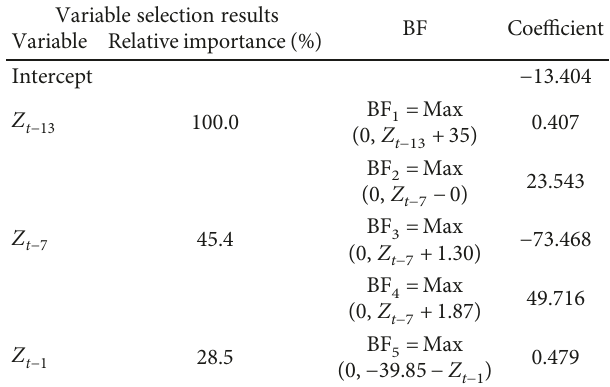
for rice price forecasting. 1